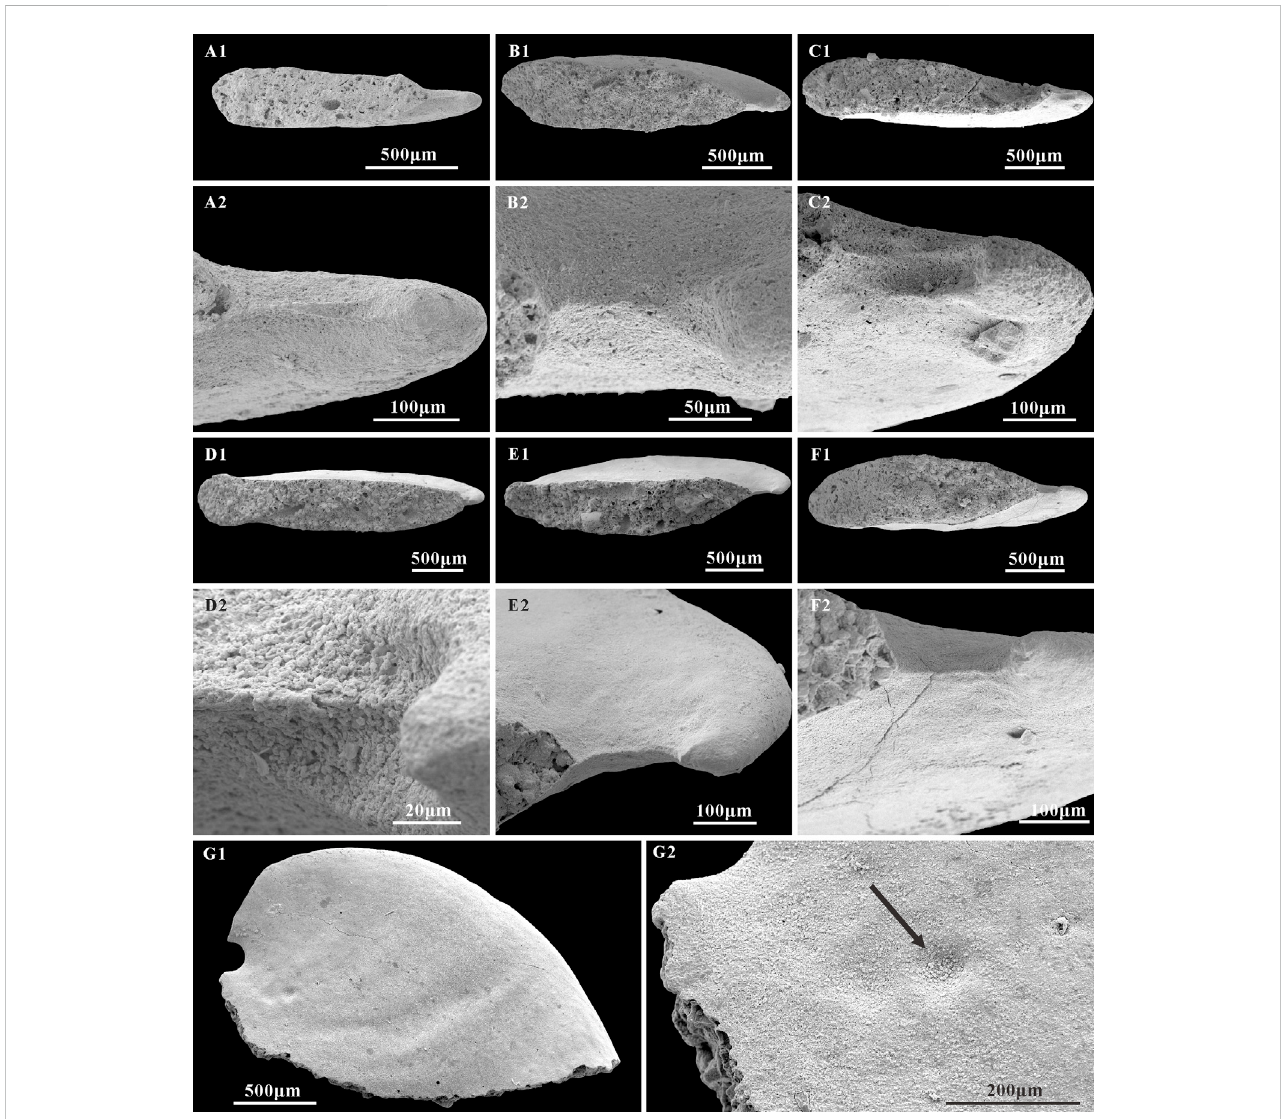
FIGURE 8 Structures on the sub-apical area of A. plana and possible imprint of scar. (A1,B1,C1,D1,E1,F1) Internal molds, apertural view, CUBar217-7, CUBar241-7, CUBar241-1, CUBar242-3, CUBar241-4, CUBar241-10, respectively. (A2,B2,C2,D2,E2,F2) magni fi cations of (A1,B1,C1,D1,E1,F1) , showing the structures of sub-apical side. (G1) internal mold, lateral view, CUBar242-7. (G2) magni fi cation of (G1) , showing the possible imprint of scar. Arrow shows the location of scar. Specimens from the Member 5 of the Yanjiahe Formation in Gunziao